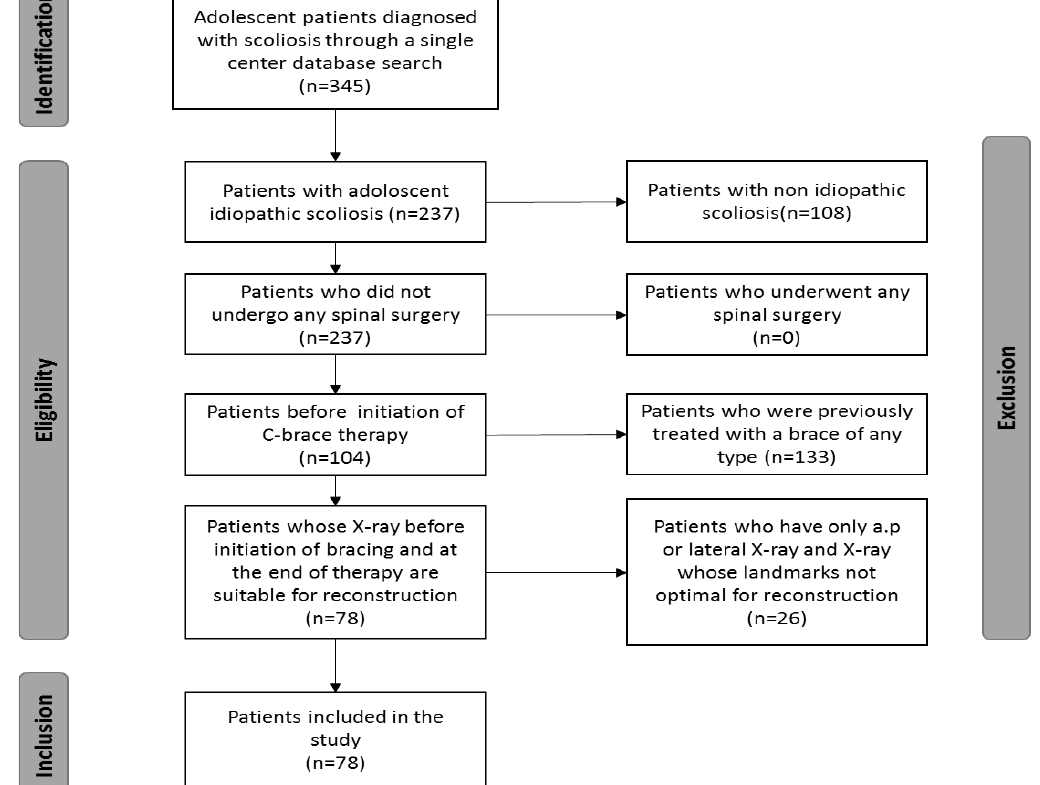
Figure 2. Diagram with inclusion and exclusion process.